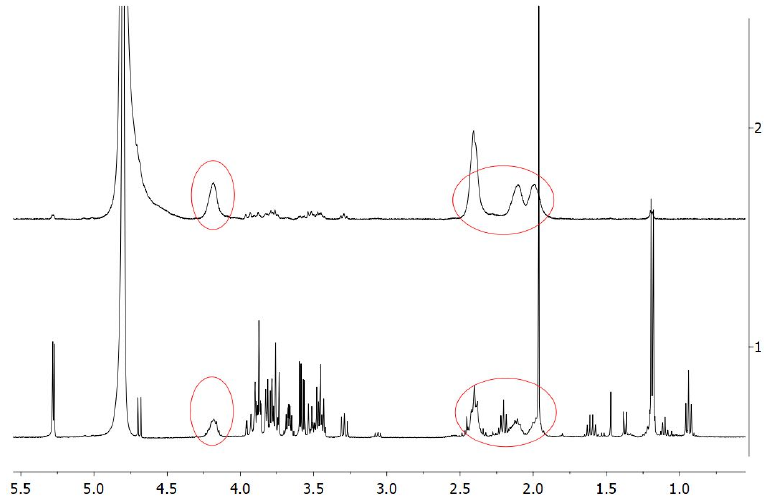
Figure 3. 1 H-NMR spectra of PGA before (lower panel) and after (upper panel) dialysis. The circled peaks indicate PGA signals [21], whereas the 4.8 ppm peak corresponds to HDO present in the solvent (D 2 O). Further experimental details are given in the text.